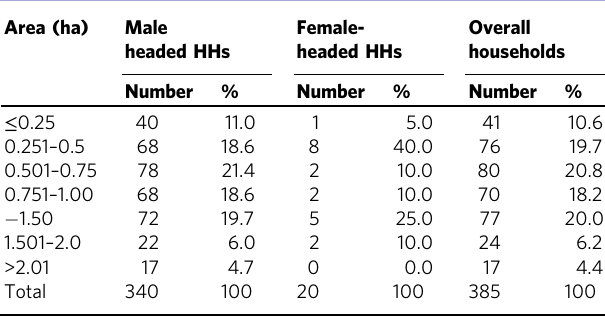
Table 6 Size (own holding or shared) of farmlands (ha) cultivated by grass pea per